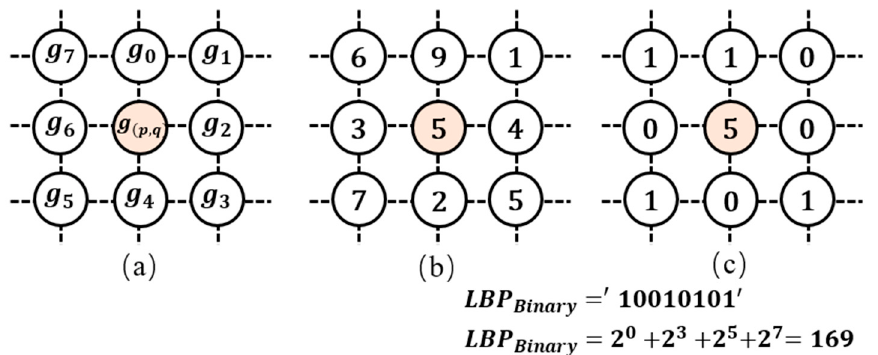
Figure 3. LBP operator in 3 × 3 neighborhood, where ( a ) center pixel g ( p , q ) with eight neighbors, ( b ) sample block, ( c ) binary labels of eight neighbors. ( b ) sample block, ( c ) binary labels of eight